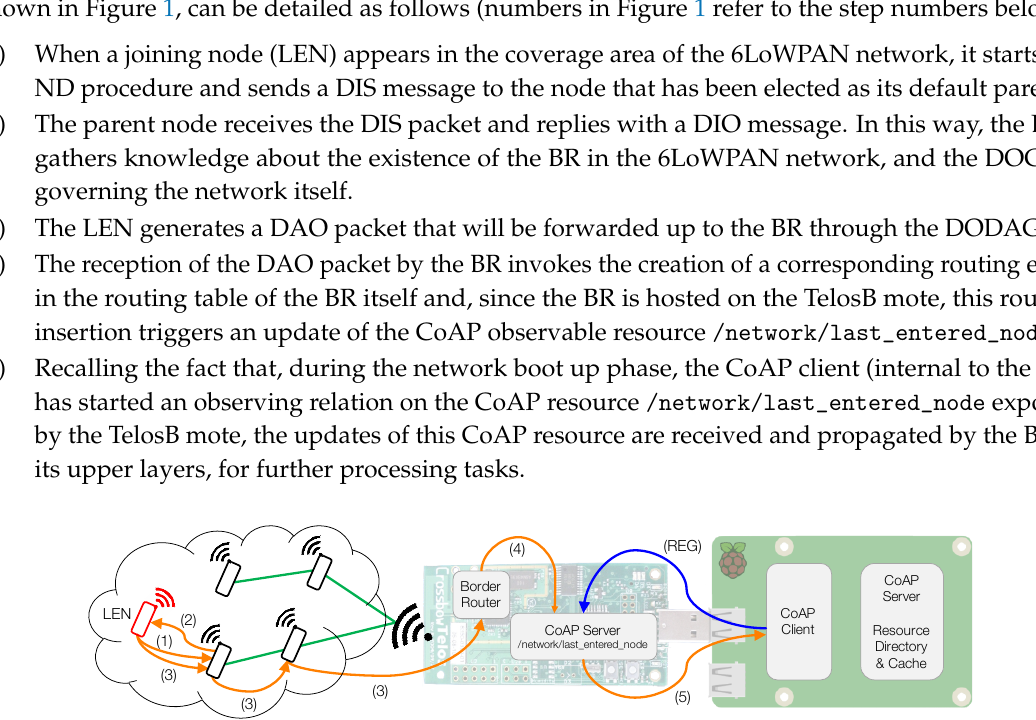
Figure 1. Node discovery procedure embedded in the RPL discovery handshake. The numbers in the figure refer to the node discovery